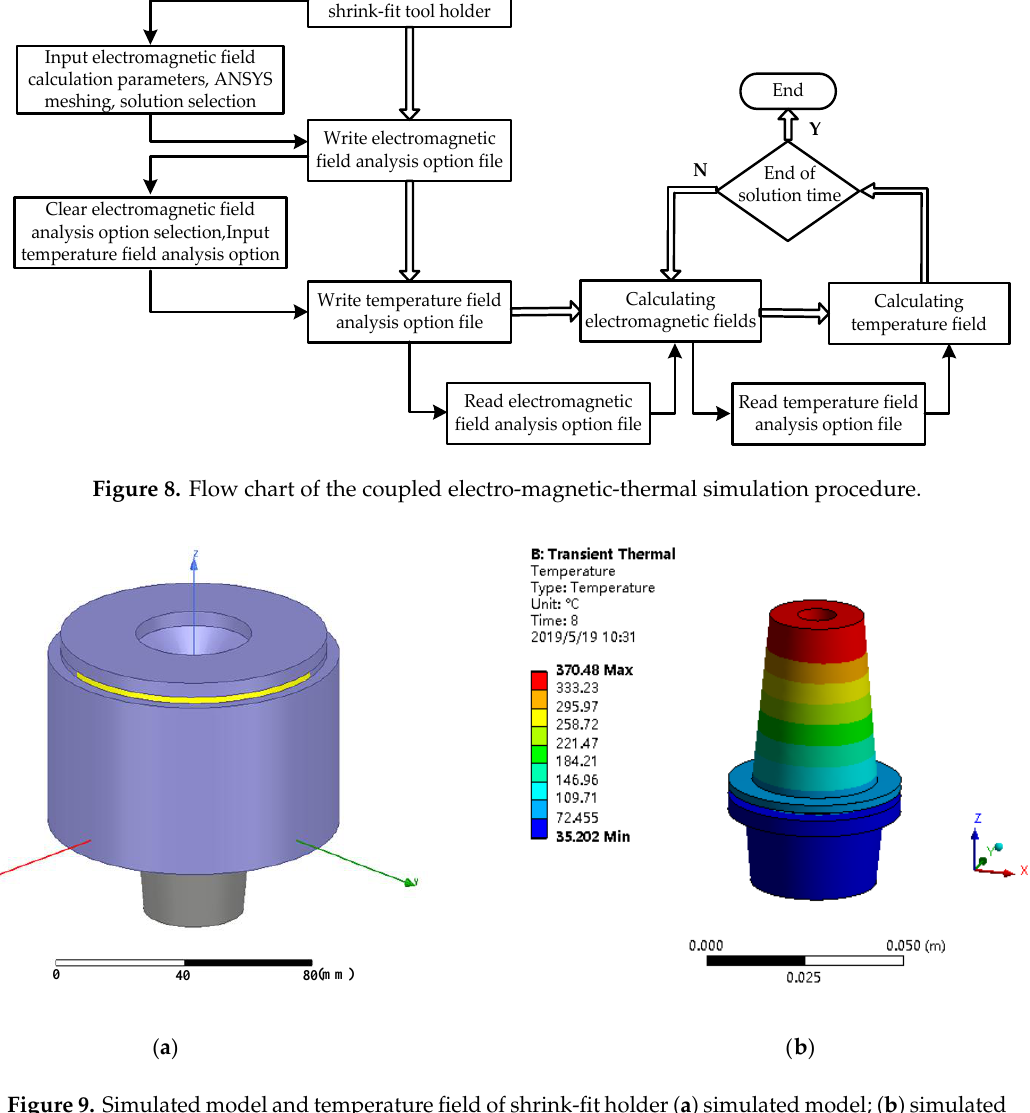
Figure 9. Simulated model and temperature field of shrink-fit holder ( a ) simulated model; ( b ) simulated temperature field.